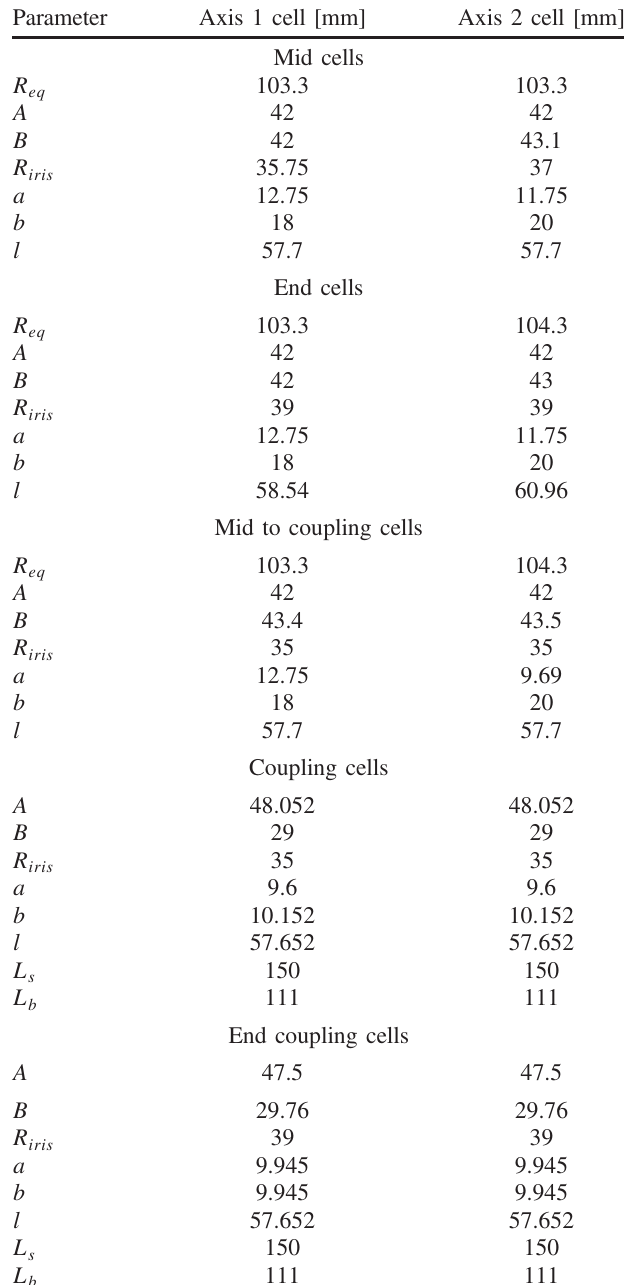
TABLE I. Parameters used to construct numerical